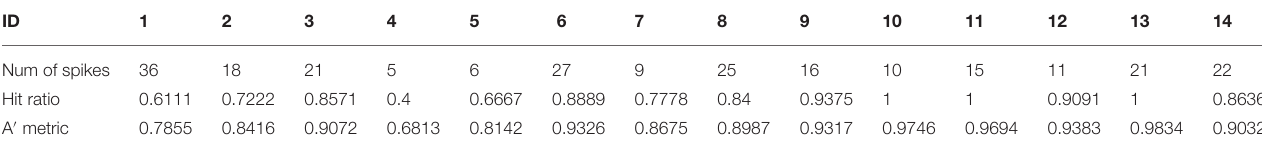
TABLE 1 | Overview of source localizations of interictal epileptiform activity recorded from 14 patients. ID